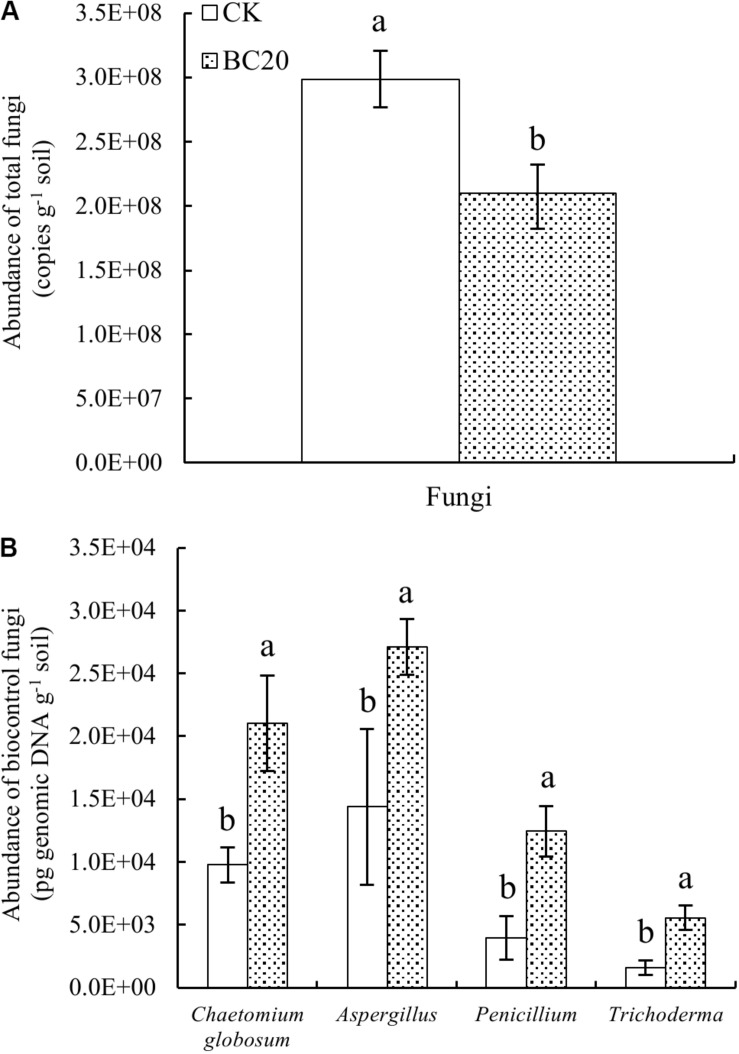
Effect of biochar amendment on the abundance of total fungi (A) and potential rhizosphere-associated biocontrol fungi (B) after incubation for 20 days. Bars represent the standard error of each mean. Different letters above columns indicate significant differences (p < 0.05) according to one-way ANOVA (n = 3).